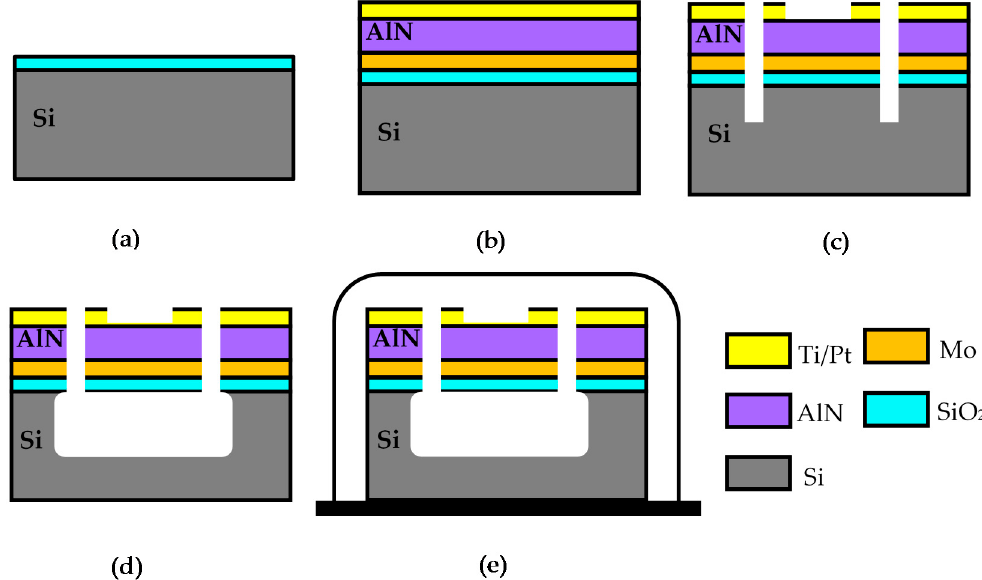
Figure 8. The fabrication process flow of the gyroscope: ( a ) The SiO 2 layer is grown by the thermal oxidation process. The thickness of SiO 2 layer is 300 nm; ( b ) The Mo layer works as the bottom electrode and is sputtered on the SiO 2 layer. The (002) oriented AlN film is sputter on the Mo layer by magnetron sputtering process. The full width at half maximum (FWHM) of AlN film is 1.288 ◦ tested by X-ray di ff raction (XRD). The Ti / Pt layer works as the top electrode, sputtered on the AlN film; ( c ) Di ff erent ICP etching processes are performed on the Ti / Pt, AlN, Mo, SiO 2 and Si successively; ( d ) The releasing process is performed by inductively coupled plasma (ICP) isotropic etching process of Si. The etching gas is SF 6 ; ( e ) The vacuum packaging of chip-level is used for sealing the